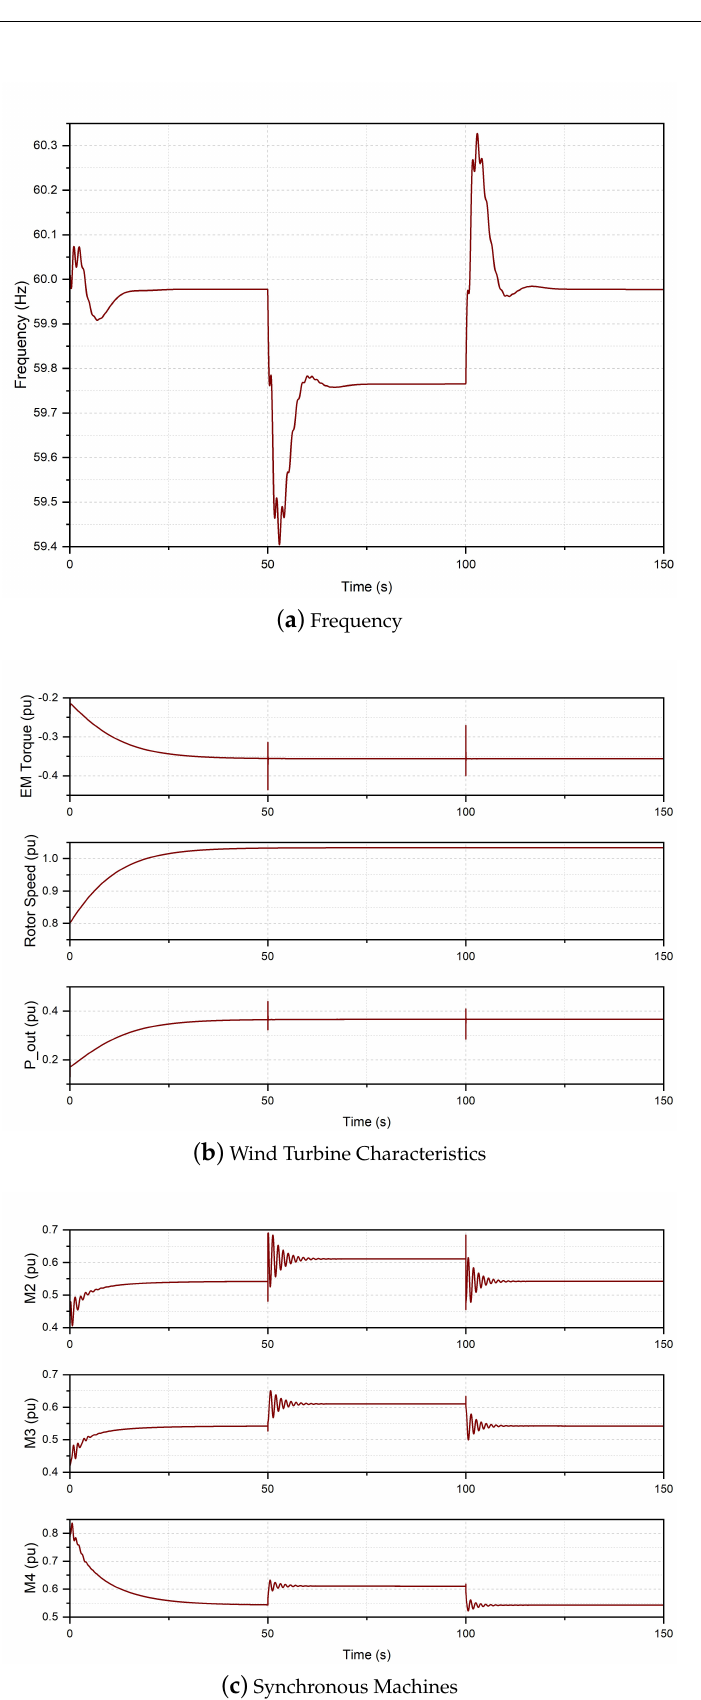
Figure 3. Behavior of grid frequency, WTs and synchronous machines during no frequency control